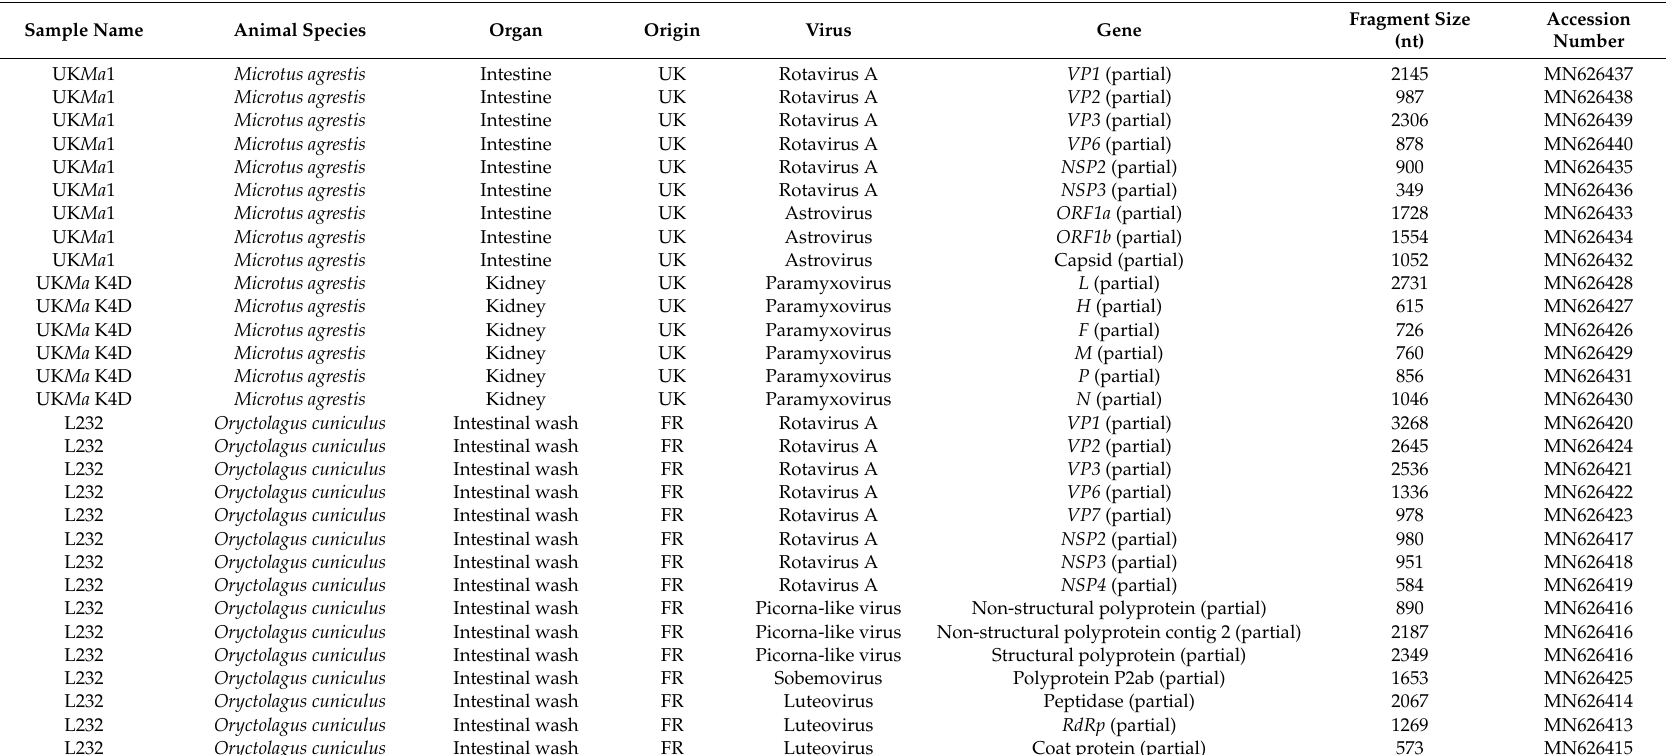
Table 1. The samples and the corresponding viral hits including virus type, gene and size of the retrieved fragment utilized